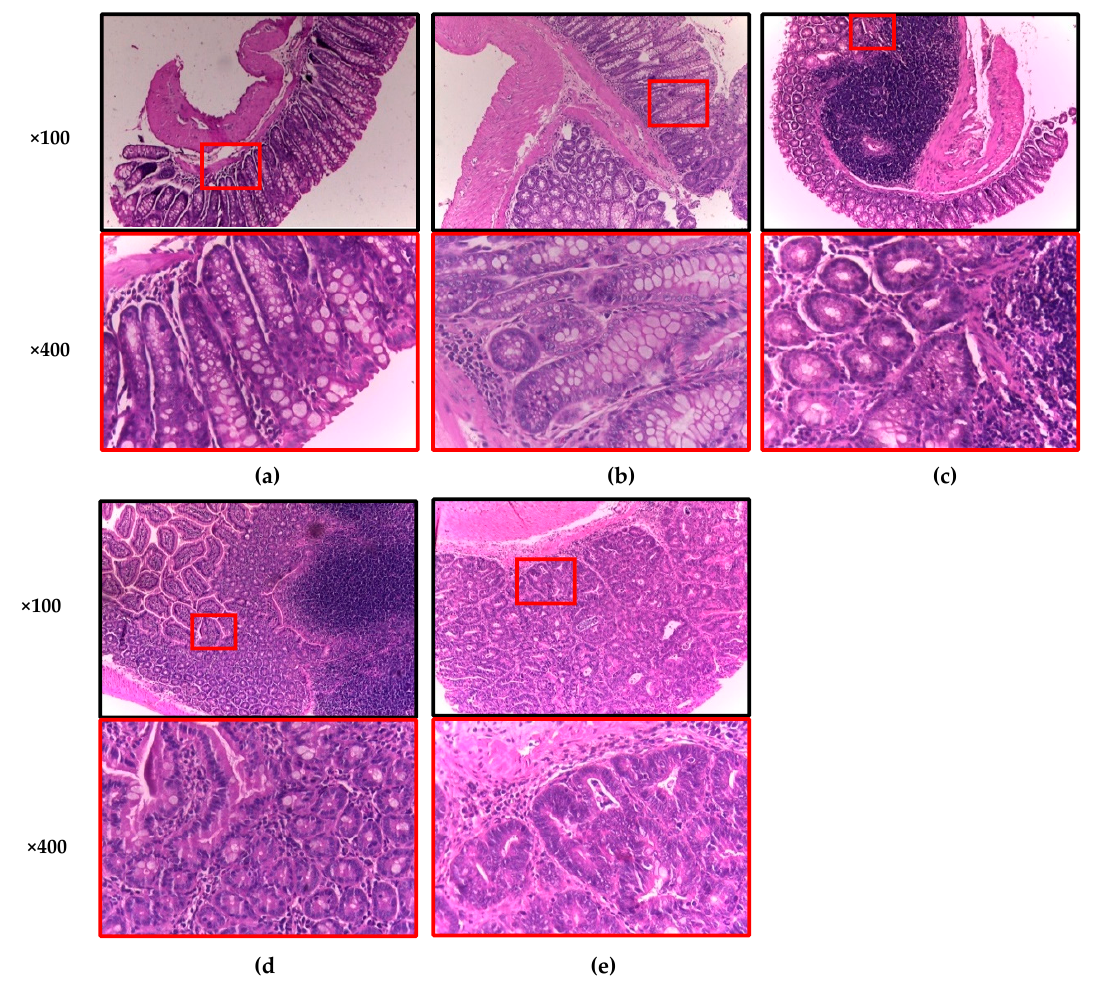
Figure 1. Histopathological examination of colonic mucosa of azoxymethane (AOM) + dextran sulfate sodium (DSS)-treated mice. Hematoxylin and eosin (H&E) staining: ( a ) Normal tissue; ( b ) low-grade inflammation ( + ); ( c ) medium-grade inflammation ( ++ ); ( d ) high-grade inflammation ( +++ ); ( e ) adenocarcinoma. n = 8–10 mice per